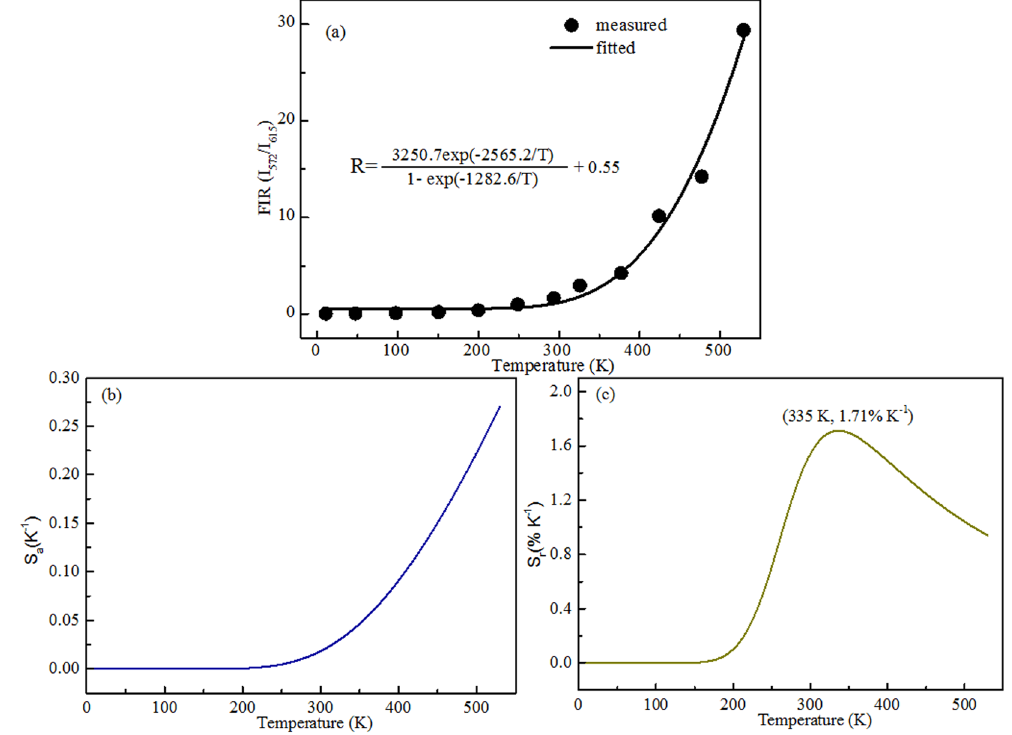
Figure 9. ( a ) Experimental measured and fitted plots of FIR (I 572 /I 615 ) versus temperature. ( b ) Absolute sensitivity S a and ( c ) Relative sensitivity S r versus